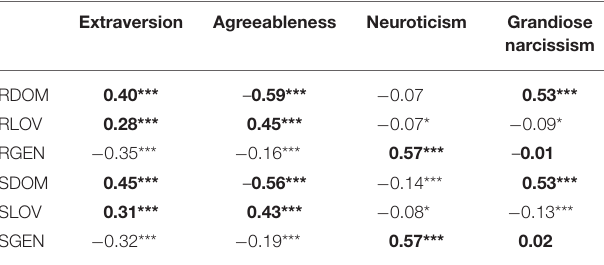
TABLE 6 | Correlations between higher-level scores of the inventory of interpersonal problems and external